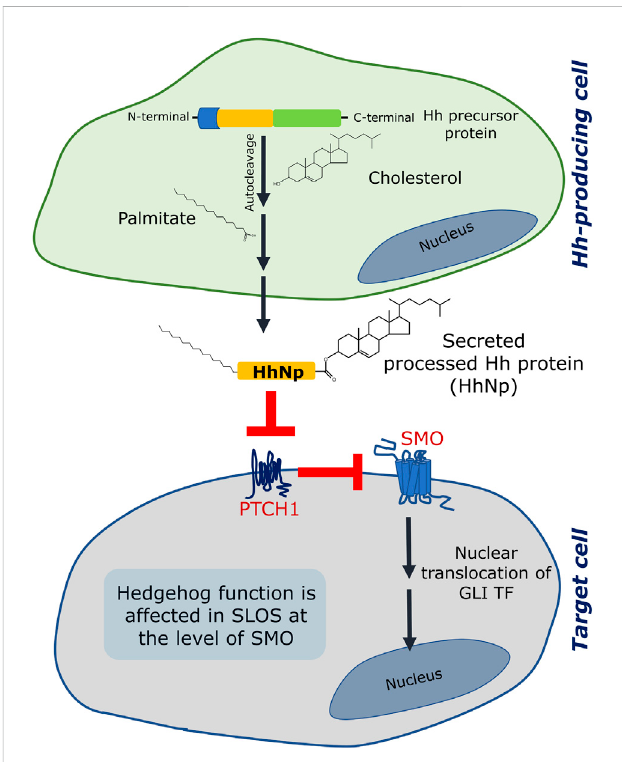
FIGURE 3 Hedgehog (Hh) signaling is affected in SLOS. Hedgehog signaling involves two sites: (i) a Hedgehog producing cell and (ii) a responding/ target cell.The Hedgehog proteinisformedas aprecursorproteininthe generating cell, which is processed by an autocleavage reaction followed by two lipid modi fi cation reactions, one of which is esteri fi cation of cholesterol to the C terminal of the processed ligand (the other one is palmitoylation). Once fully processed, the Hh ligand (designated as HhNp) is secreted to the target cell. In a target cell, two transmembrane proteins (Patched 1 (PTCH1) and Smoothened (SMO)) act consecutively in response to the Hh (HhNp) ligand. In absence of the ligand, PTCH1 inhibits SMO and therefore inhibits signaling. The Hh ligand binds and inhibits PTCH1 which leads to activation of SMO and subsequent signaling terminating in activation and nuclear translocation of GLI transcription factors (TF). Hedgehog signaling is affected in SLOS at the level of SMO, which could be due to inef fi ciency of 7-DHC to activate SMO or due to lack of cholesterol. See text for more